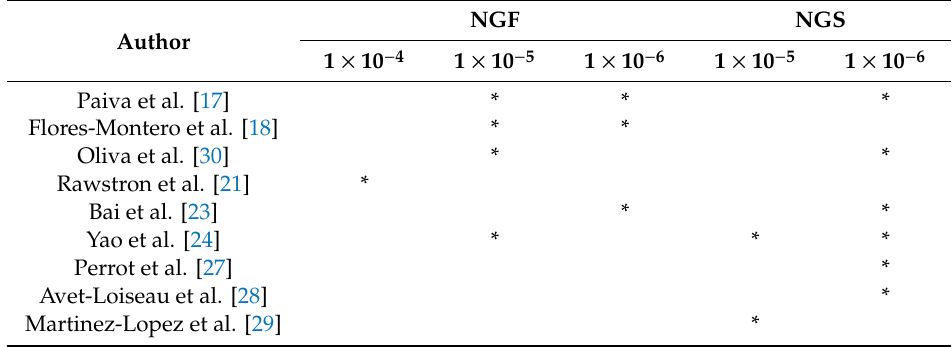
Table 1. Next-generation flow (NGF) and next-generation sequencing (NGS) studies on reported MRD in the literature. The symbol * indicate the studies in the